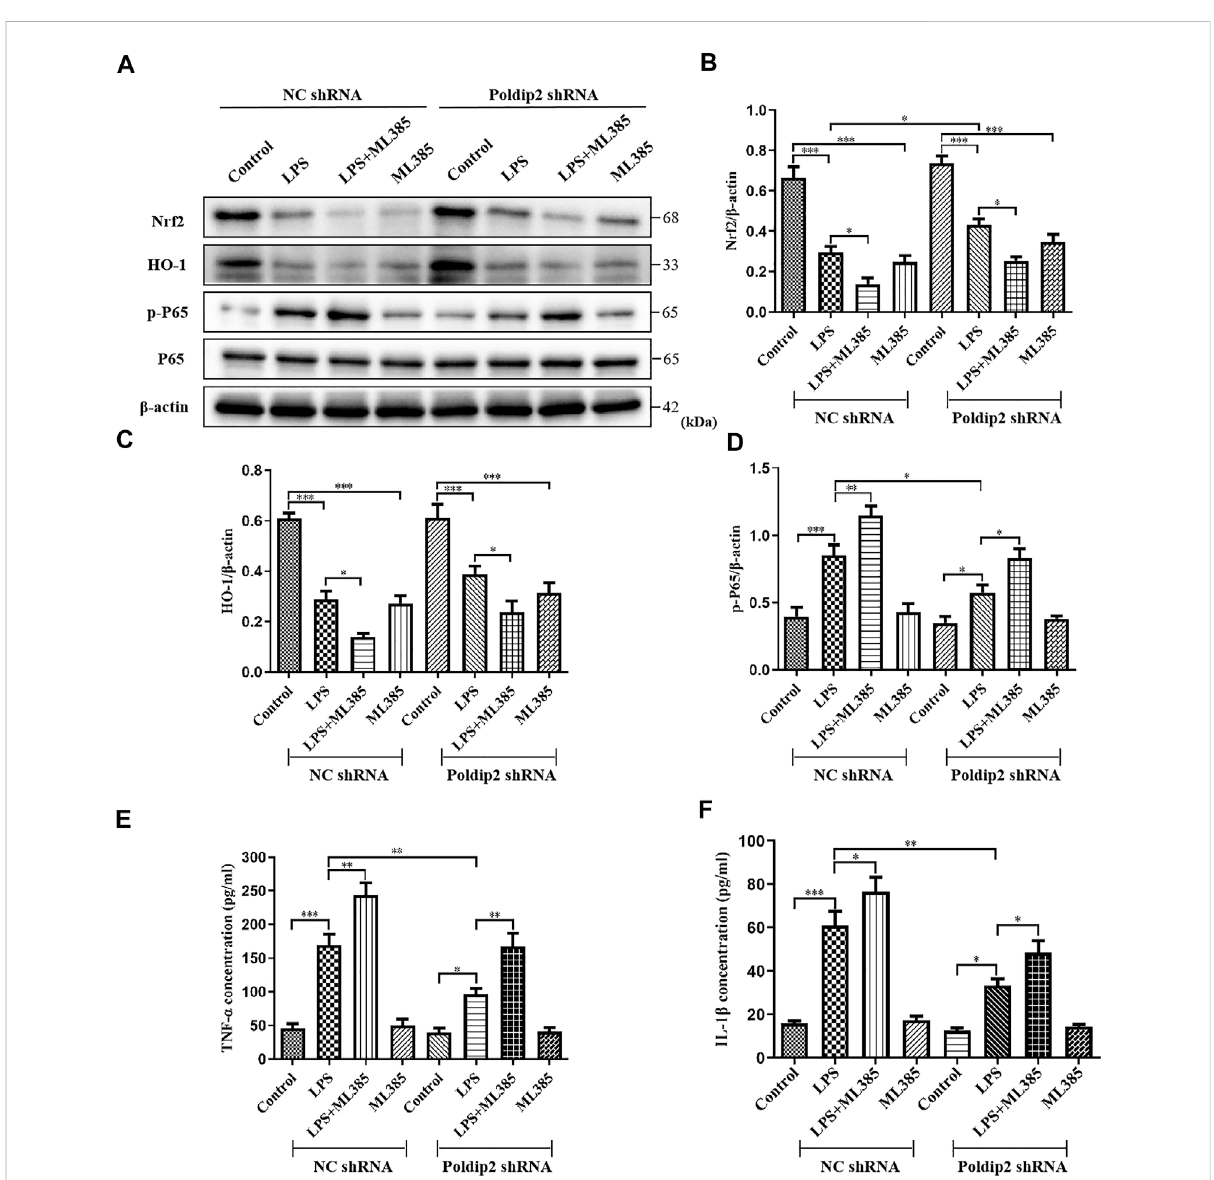
FIGURE 5 Protective effects of Poldip2 knockdown in attenuating oxidative stress and the resulting in fl ammation are reversed by ML385. Transfected A549 cells (NC shRNA or Poldip2 shRNA) were pretreated with or without 5 μ M ML385 for 1 h, and treated with 10 μ g/ml LPS for 12 h (A – D) The protein levels of Nrf2, HO-1, p-P65 and P65 were detected by western blot (A) and quantitatively analyzed (B – D) . (E,F) The levels of TNF- α and IL-1 β in the supernatant were detected by ELISA. Results are represented as mean ± SEM of three independent experiments. Statistically signi fi cant differences are indicated as *** p < 0.001,** p < 0.01, * p <